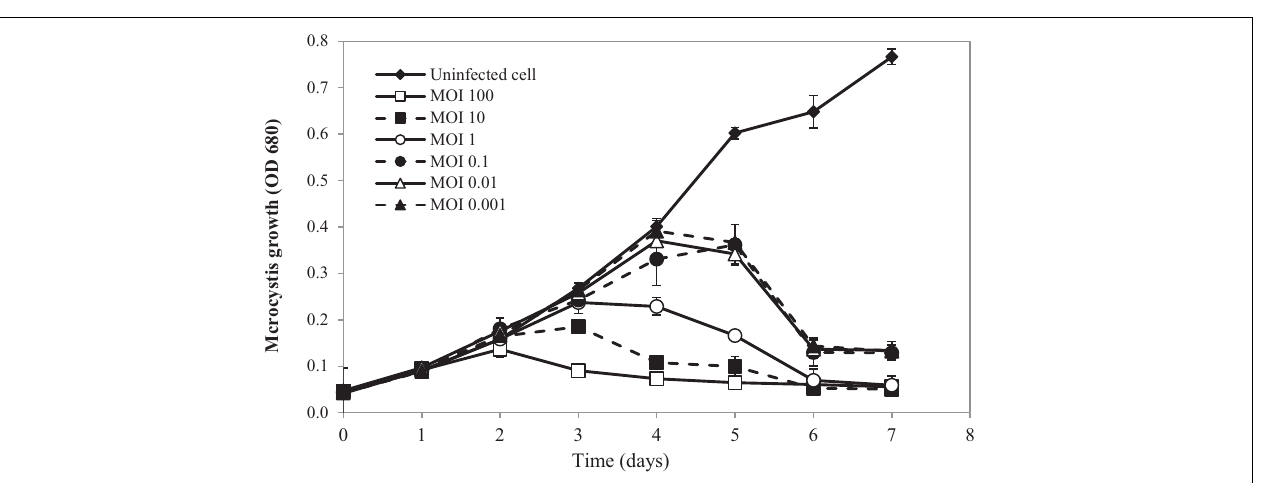
FIGURE 4 | Time killing assay of cyanophage PhiMa05 against Microcystis SG03. The bacterial cultures were infected with the cyanophage at MOIs of 0.001, 0.01, 0.1, 1, 10, and 100. Uninfected bacterial culture was used as a control. Independent experiments were conducted in triplicate and optical density at 680 nm was measured, averaged, and plotted. Error bars are standard